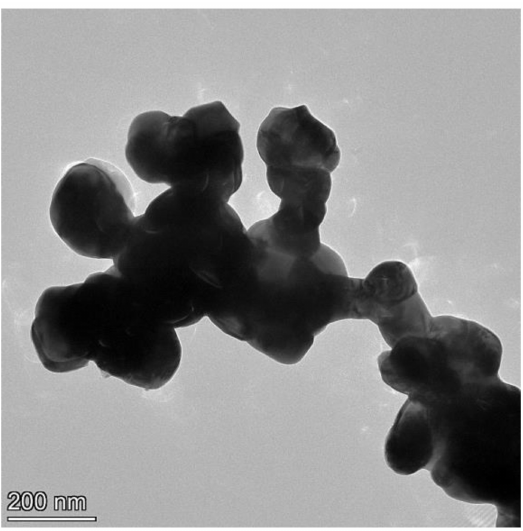
Figure 16. TEM image of Cu-20 wt%W reduced